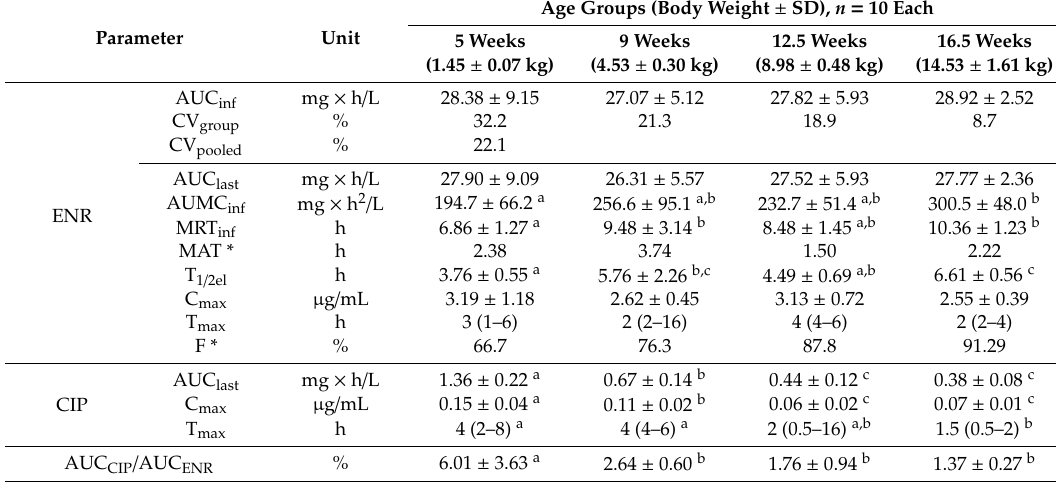
Table 2. Pharmacokinetic parameters after single oral enrofloxacin administration to turkeys dosed according to the protocol: Dose = 30 × BW 0.59